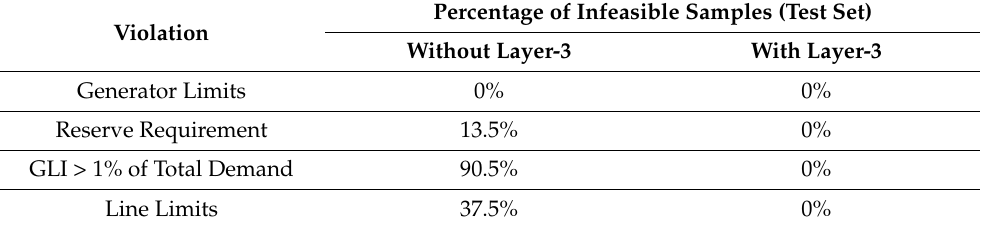
Table 8. Layer-3 Performance (IEEE 39-Bus System).